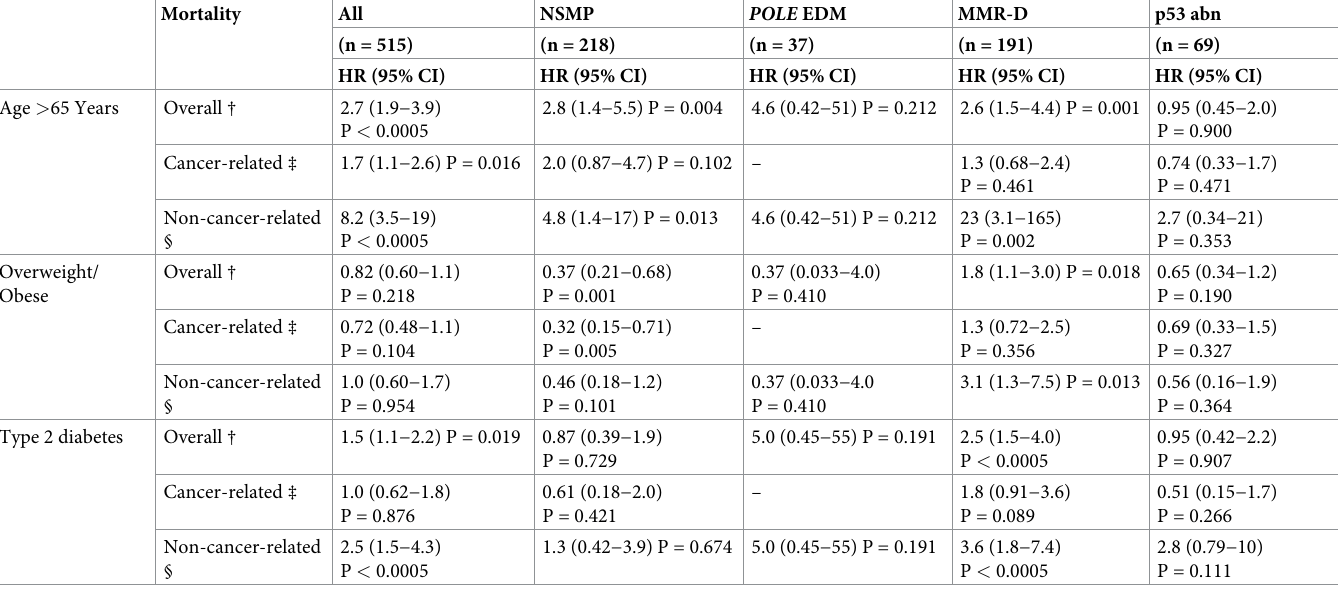
Table 2. Univariable Cox regression analyses of overall, cancer-related and non-cancer-related mortality.